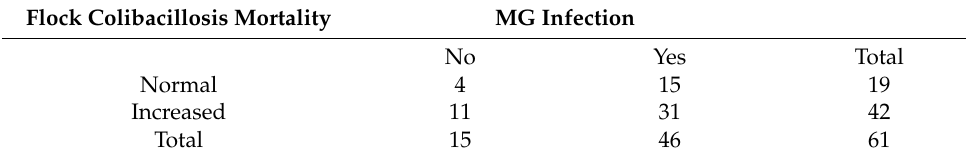
Table 7. Status of MS infection among sampled flocks (MS: Mycoplasma synoviae ). Flock Colibacillosis